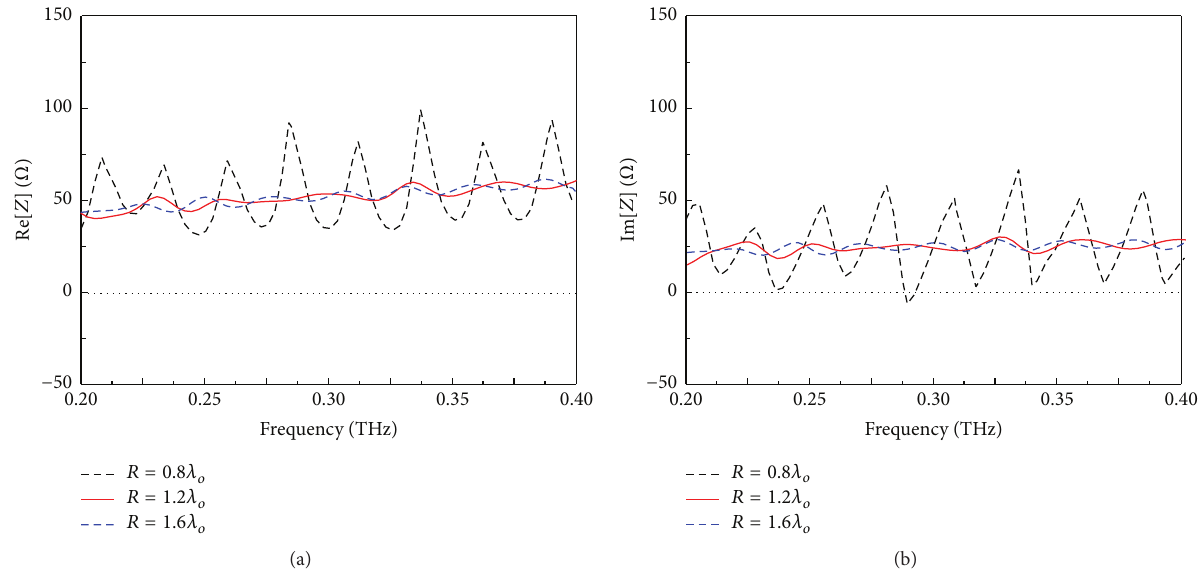
Figure 5: Comparison plots of input impedance versus frequency for different values of R with 𝑇/𝑅 = 0.34: (a) real part and (b) imaginary part.